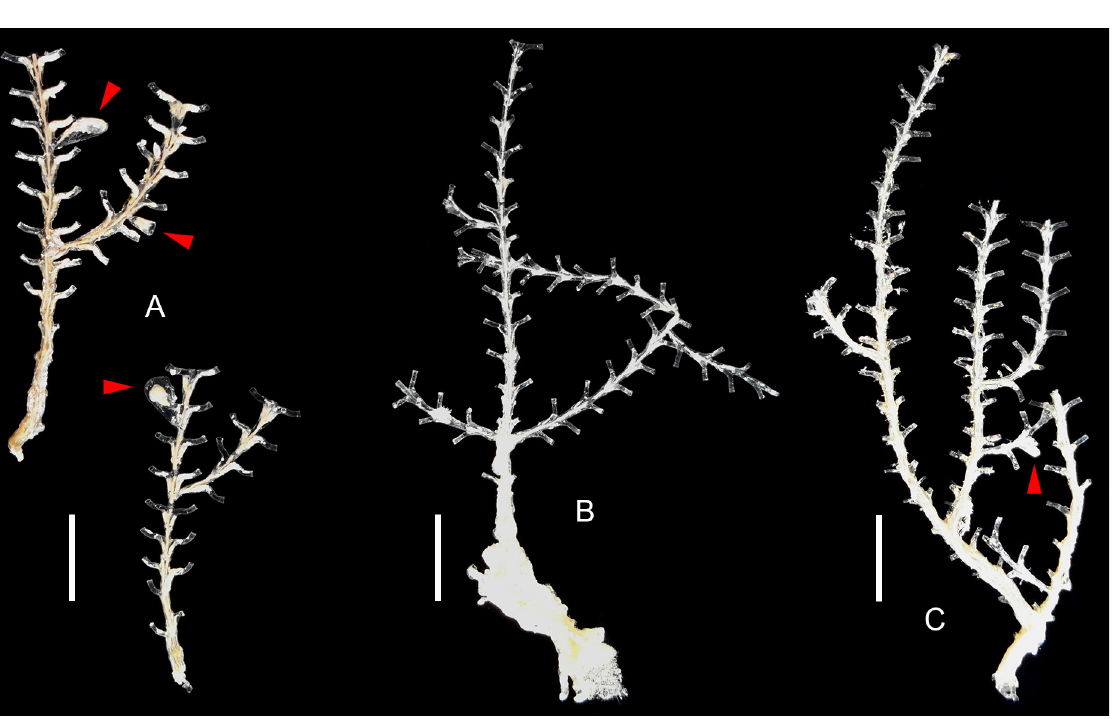
Fig. 1. A . Caledoniana alata gen. et sp. nov., holotype (below) and paratype (above). B . Caledoniana decussata gen. et sp. nov., colony silhouette (part of holotype). C . Caledoniana microgona gen. et sp. nov., colony silhouette (holotype). The red arrows indicate the presence of gonothecae. Scale bars: 1